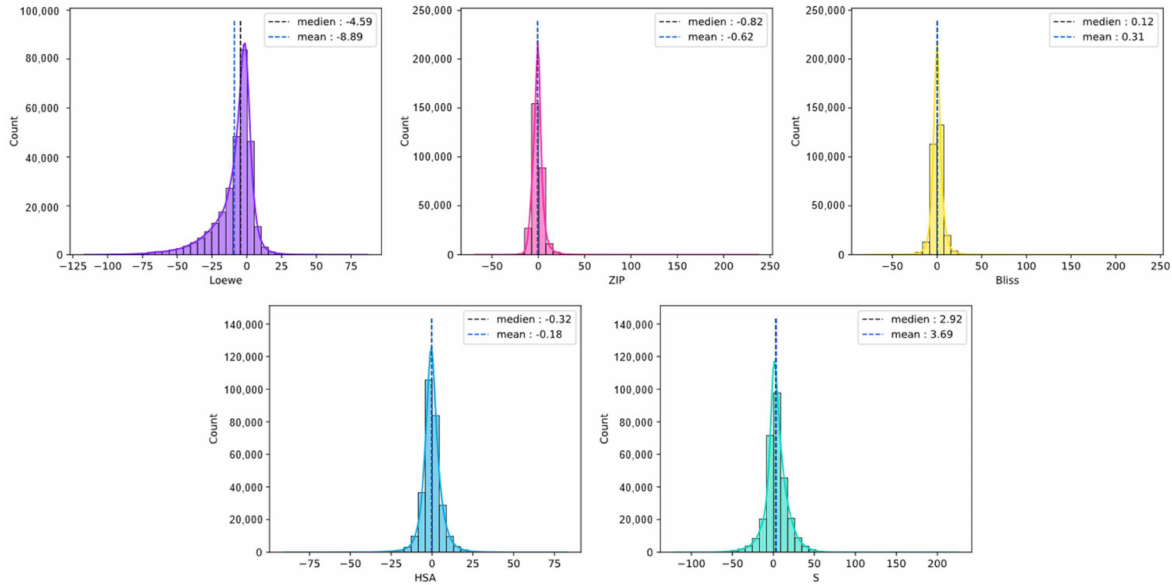
Figure 8. The distribution of different synergy scores in the